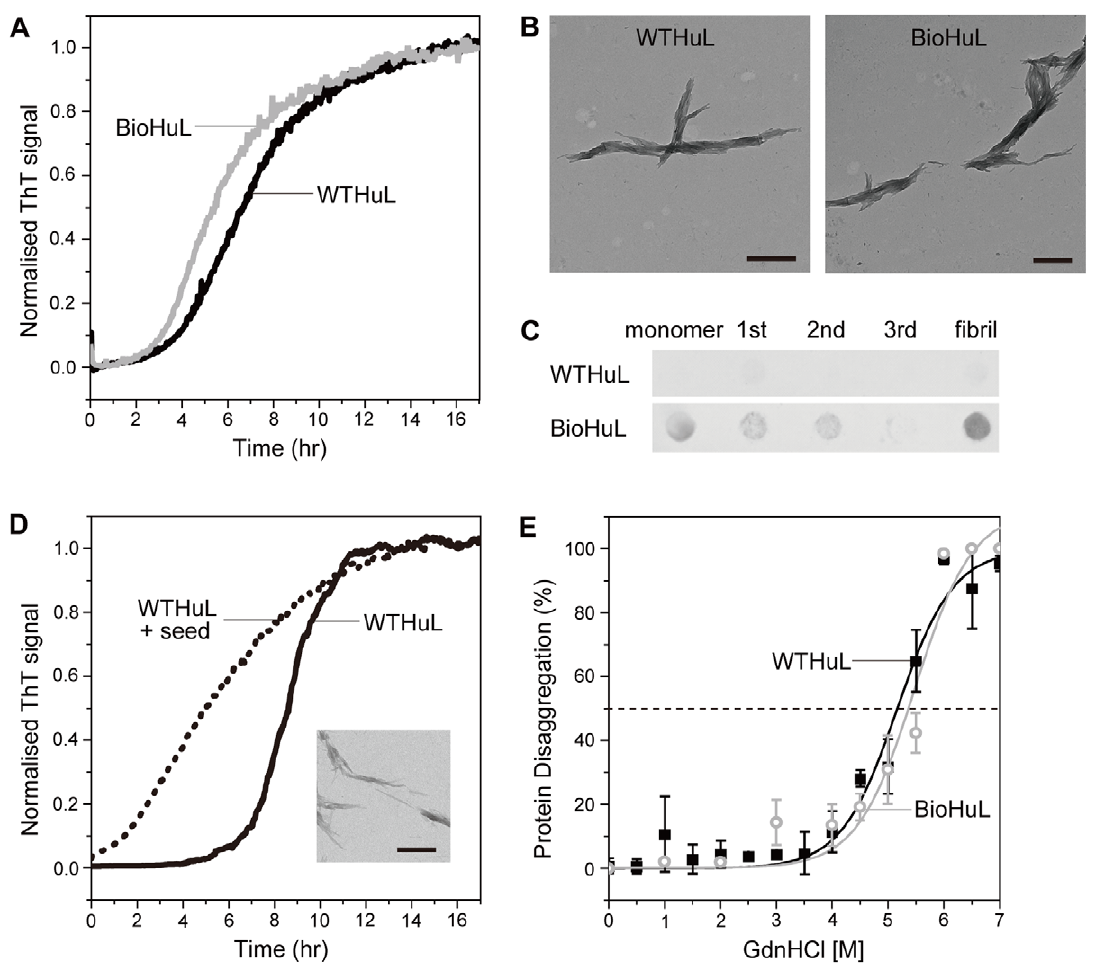
Figure 3. Fibril formation of BioHuL. (A) In situ Thio-T binding fluorescence kinetics of BioHuL (grey) and WTHuL (black) incubated in the presence of 3 M urea in 0.1 M citrate buffer (pH 5.0) with constant stirring at 60 u C. (B) TEM images of the endpoint samples of the aggregation reactions performed in the absence Thio-T. Images on the left and right show the fibrils formed by WTHuL and BioHuL, respectively; the scale bars represent 500 nm. (C) Dot blot assay of fibrils formed by WTHuL (upper row) and BioHuL (bottom row). Samples include the monomeric protein, the supernatant solutions after washing the fibril pellets (1 st , 2 nd , and 3 rd ) and the final washed fibrils. The appearance of colour indicates a positive interaction between biotin and streptavidin-AP. (D) In situ Thio-T binding fluorescence kinetics of WTHuL in the absence (solid line) and presence of 10% BioHuL fibril seeds (dashed line) incubated under similar conditions as (A). (Inset) TEM images of the WTHuL fibrils formed in the presence of BioHuL fibril seeds; the scale bar represents 500 nm. (E) Conformational stability of BioHuL (grey open circles) and WTHuL (black squares) fibrils. The stability of the fibrils was measured by depolymerisation experiments performed using GdnHCl at pH 5.0. Continuous lines represent the best fits to sigmoidal functions. stability of the BioHuL and WTHuL fibrils, we measured the resistance of the fibrils to depolymerisation by incubating fibril aliquots in solutions containing guanidinium hydrochloride (GdnHCl) and measuring the concentration of soluble monomer released into the supernatant. The plots of the fraction of soluble protein present at increasing GdnHCl concentrations are shown in Figure 3E. Both the BioHuL and WTHuL fibrils have similar midpoints of depolymerisation, 5.5 6 0.5 M and 5.2 6 0.3 M respectively, therefore demonstrating similar conformational stability.